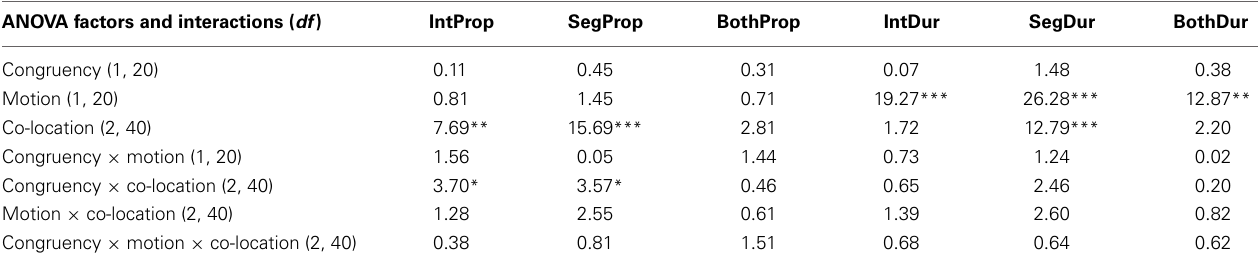
Table 1 | F values yielded by the ANOVAs for the overall phase proportions and phase durations for the factors of Congruency ( Congruent or Incongruent ), Motion ( Stationary or Moving ), and Co-location ( Identical, Joint or Separate ). ANOVA factors and interactions ( df )